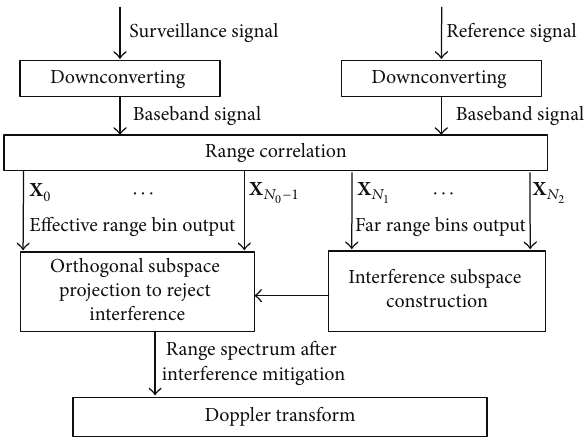
Figure 1: Flow chart of processing steps for RFI mitigation. of the range-domain mitigation. An orthogonal projection filtering method for RFI mitigation in HFPBR is introduced in the following. The processing diagram is given in Figure